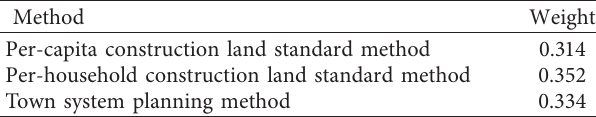
Table 4: Results of determining the weights of the three methods.